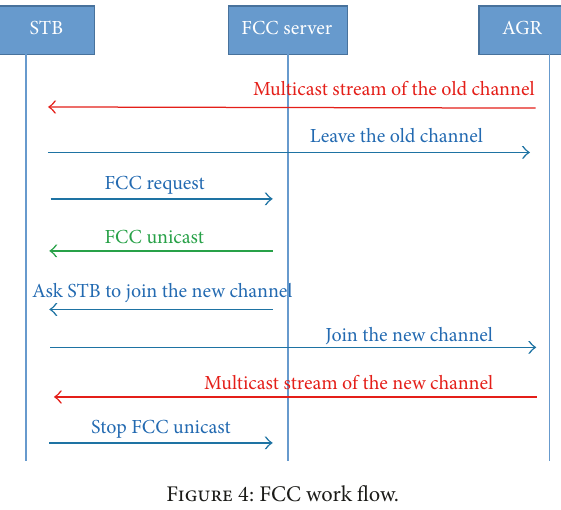
Figure 4: FCC work